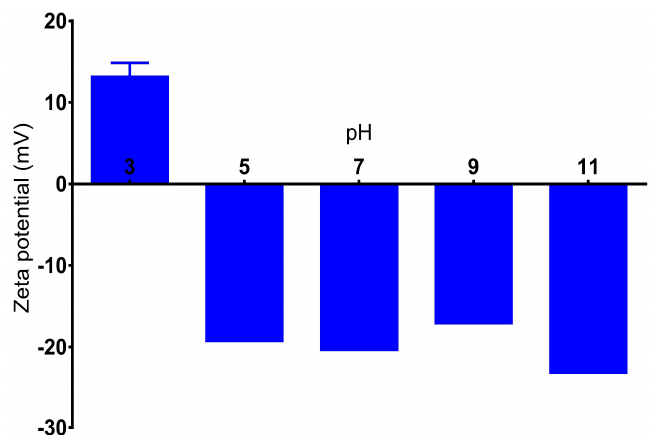
Figure 10. The influence of pH on the zeta potential of BSA nanoparticles prepared in 1 mM NaCl. Measurements from separate assays were combined ( n = 6) and showed in mean ± SD.